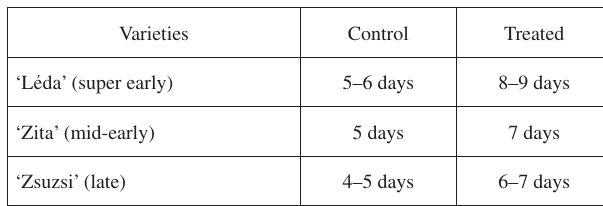
Table 1. Length of the maturation